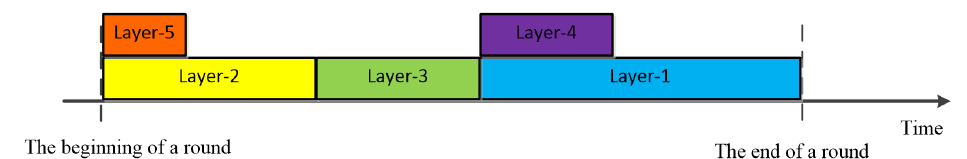
Figure 5. Overlapped slot division of a five-hop data collection network in